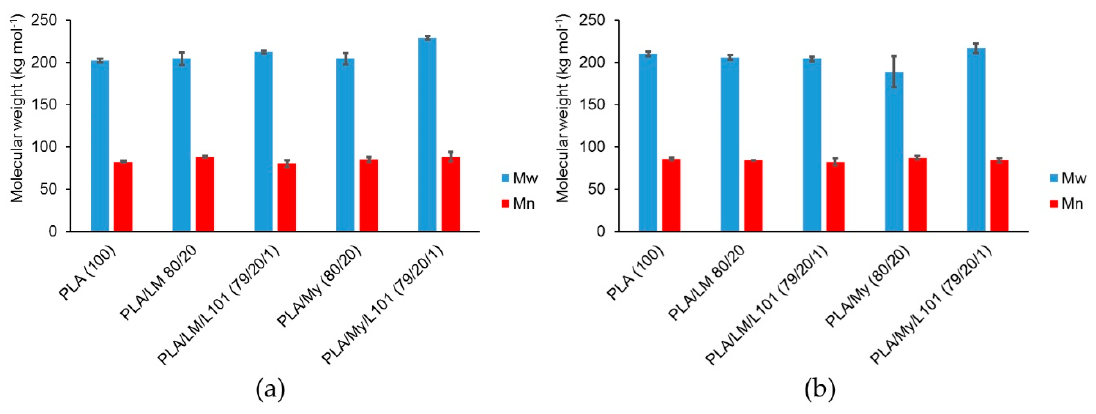
Figure 2. Molecular weights M w and M n of polylactide (PLA)-based materials determined by size exclusion chromatography (SEC) after extrusion ( a ), and after extrusion and injection molding ( b ) (with standard deviations).